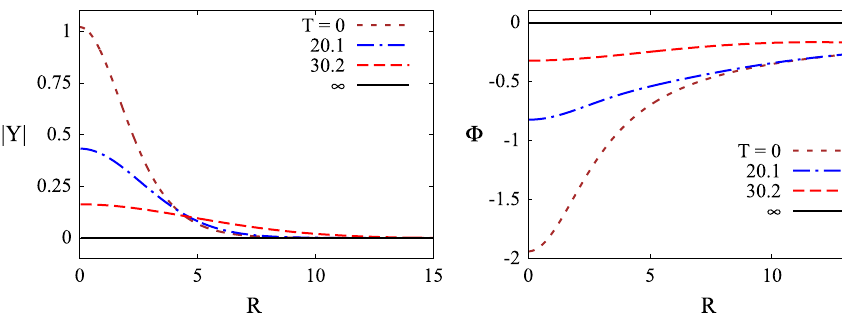
Fig. 12 Spreading of the Q-ball with Ω in = 0 .